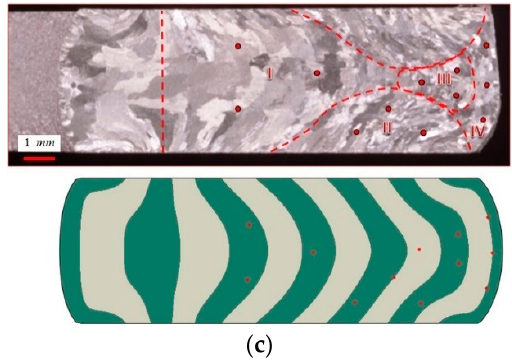
Figure 16. Segmentation into parts with different texture: Pre-deformed microstructure of ( a ) specimen R5 ( b ) and R13 ( c ). Metallography ( top ) is presented against numerically obtained flow lines ( bottom ). Locations of nodes from which data was extracted are marked in red. Metallography includes also the notation of the zones.